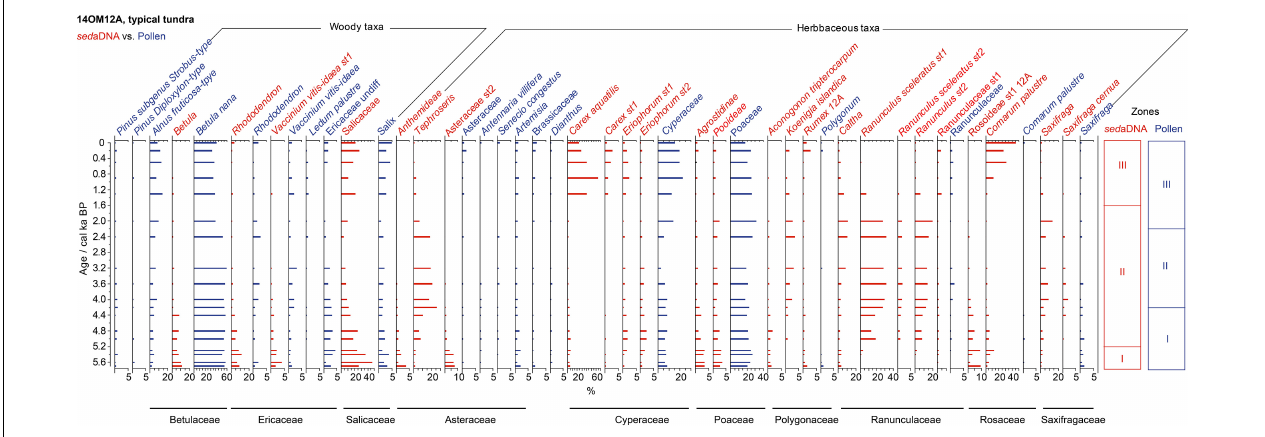
FIGURE 3 | Percentages of selected taxa/sequences over the past 5.7 ka from the modern typical tundra site (14OM12A) in the Omoloy region used in our statistical analyses, shown as red bar plots of relative read abundance of sed aDNA and blue bar plots of pollen percentages. The families detected by both sed aDNA and pollen analyses are marked as black lines. CONISS zones for each proxy are shown on the